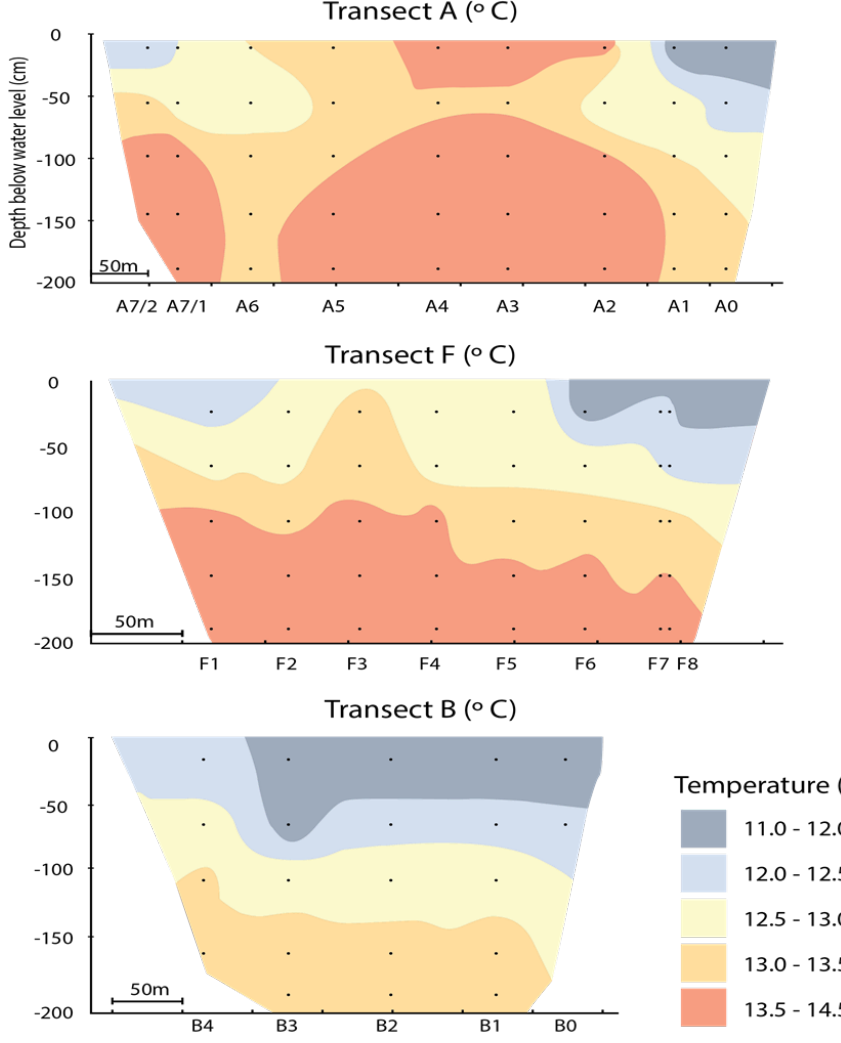
Figure 4. Temperature profiles in °C for three transects (A,B and F) measured on 11–13 May 2016. Transect B is situated in the North, while transect A is situated in the South, with transect F in the middle. Black dots represent the measuring depths.